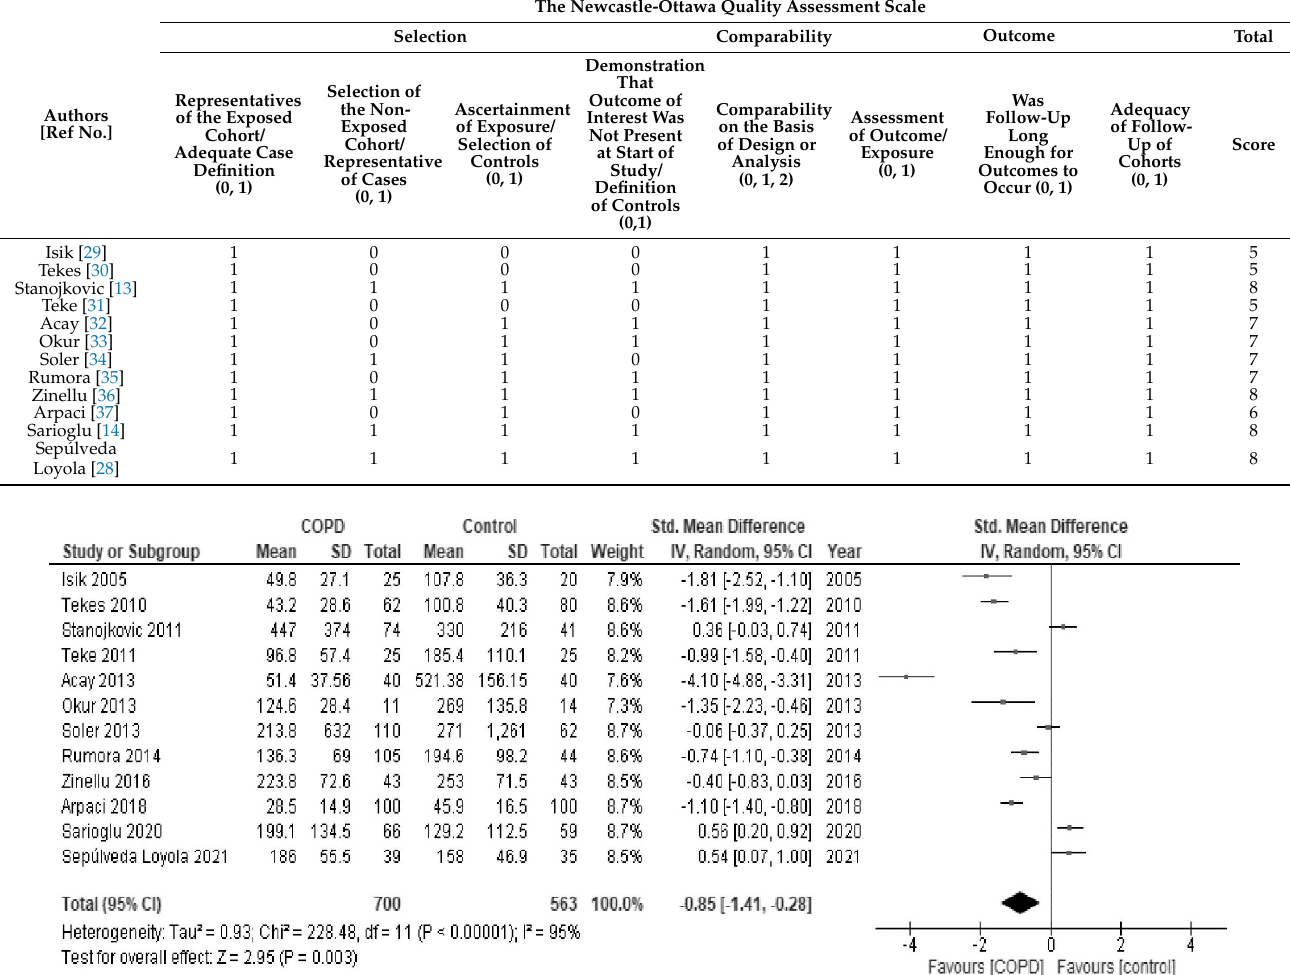
Table 2. Study quality of the included studies.